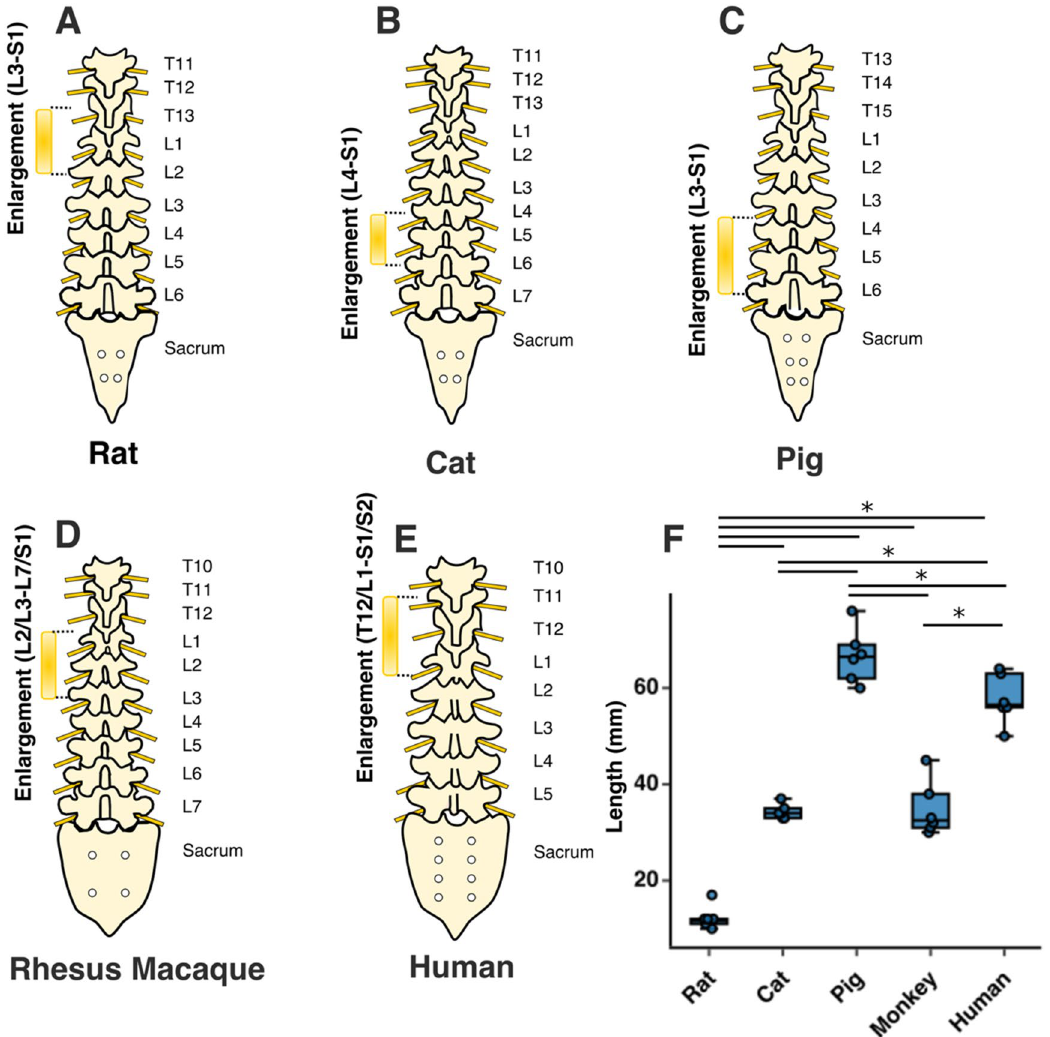
Figure 3. Rostrocaudal extent and location of the lumbosacral enlargement in various species. The typical segmental levels of the lumbosacral enlargement were: L3-S1 for rats, L4-S1 for cats, L3-S1 for pigs, L2/ L3-L7/S1 for rhesus macaque, and T12/L1-S1/S2 for humans. Levels for enlargement (in brackets) are spinal cord segments; the levels on the right side of the spinal column indicate the vertebral levels. Boxes represent interquartile range; horizontal line shows the median; whiskers represent minimum and maximum values of the dataset. ‘*’ symbol represents p < 0.05. Solid dots show individual data